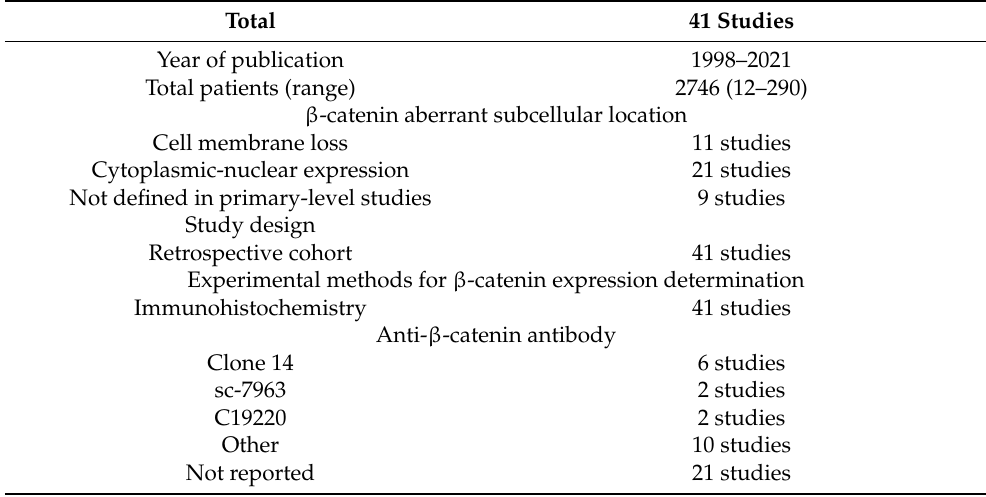
Figure 1. Flow diagram showing the identification and selection process of relevant studies, analysing the prognostic and clinicopathological significance of the aberrant expression of β -catenin in OSCC. Table 1. Summarized characteristics of the study